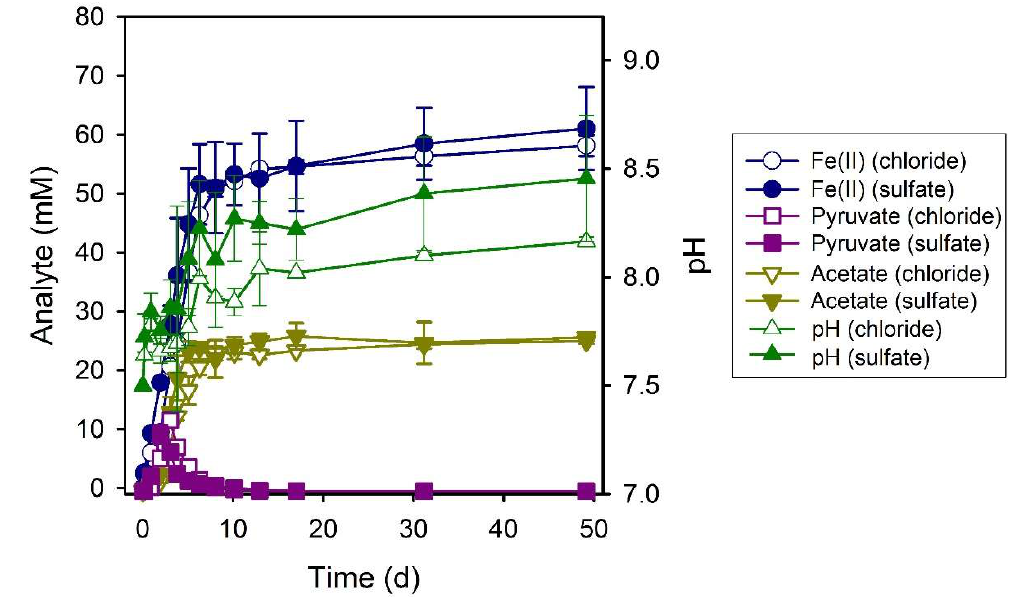
Figure 14. Fe(II), acetate, and pyruvate production/consumption and pH during the bioreduction of lepidocrocite by S. putrefaciens CN32 with serine as the electron donor.